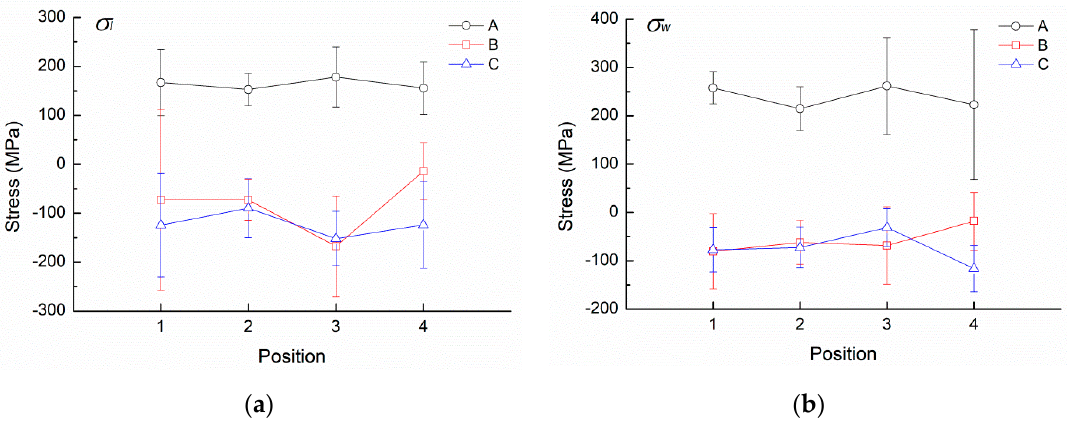
Figure 4. Results of residual stress measurement: ( a ) σ l ; ( b ) σ w . (A, B, and C denote the specimens built along the thickness, width, and length directions, respectively, as shown in Figure